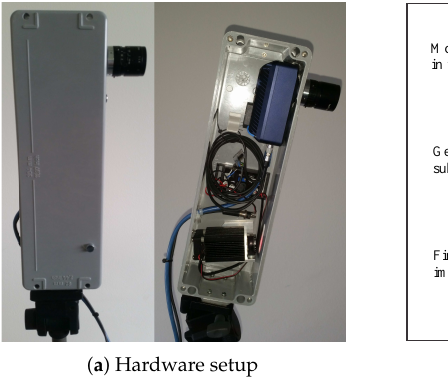
Figure 2. The acquisition procedure. ( a ) Visual appearance of the hardware setup of the ATRIS sensor. The left side of the image shows the casing of the sensor and the right side the arrangement of the camera (above) and the laser projector (below) in the casing. ( b ) Illustration of the modulated acquisition